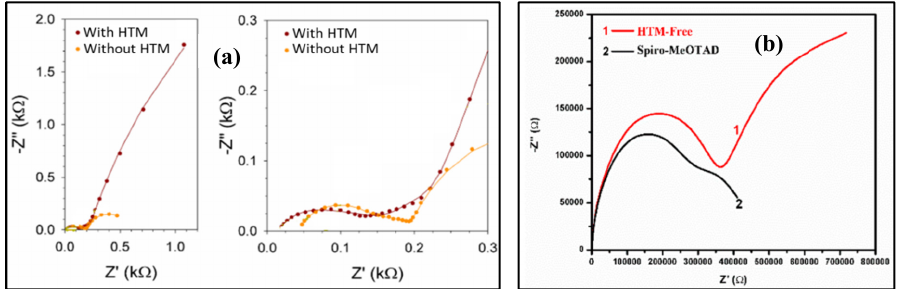
Figure 7. Nyquist plot with HTM and HTM-free carbon counter electrode-based PSCs: ( a ) obtained at a DC bias of 0.1 V under 1 sun illumination (Reproduced with permission from [25]. American Chemical Society, 2014.); and ( b ) obtained at DC bias of 0 V in the dark [28].